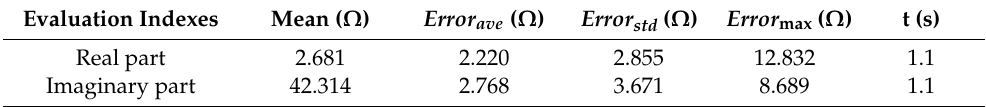
Table 10. Evaluation indexes of method 3 in 7th harmonic.